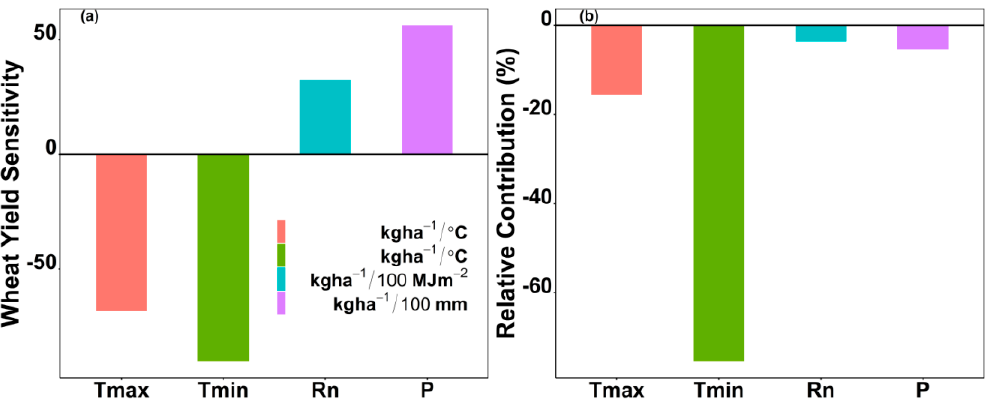
Figure 4. Trends of ( a ) wheat production, ( c ) cultivation area and ( e ) yield during 1980–2017. The right-hand panel (Figure 4 b , d , f ) shows the deviations of the three variables from their respective long-term (1980–2017) averaged values during each wheat season. Red lines in Figure 4 a – c show the trends of the climate variables and the grey region represents the 95% confidence interval.